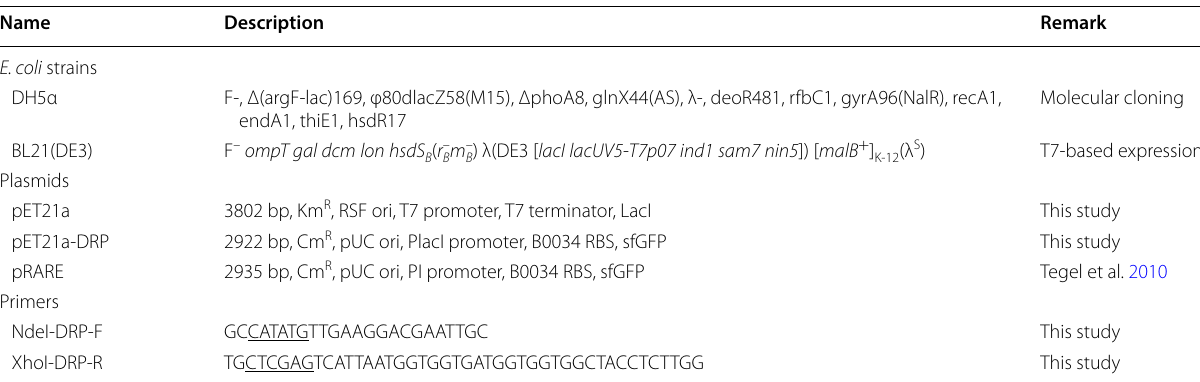
Table 1 Strains, plasmids and primers used in this study